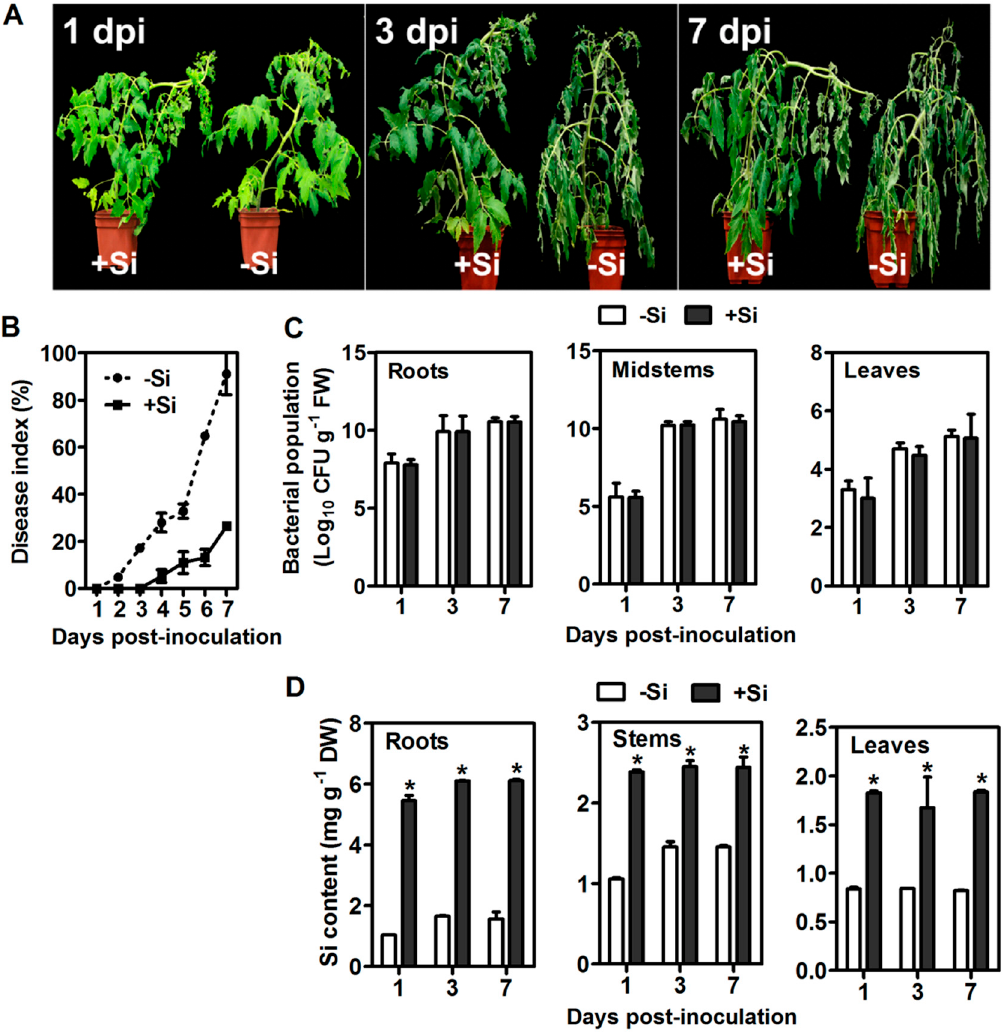
Figure 1. Responses of silicon (Si)-treated (+Si) and non-Si-treated ( − Si) tomato plants to R. solanacearum infection. ( A ) Disease symptoms. ( B ) Disease index. ( C ) Bacterial population. FW: fresh weight. ( D ) Si content. DW: dry weight. Data presented are means ± standard error (SE) of three replicates. Asterisks denote a significant difference between treatments at the same time-point (Student’s t -test, p < 0.05).